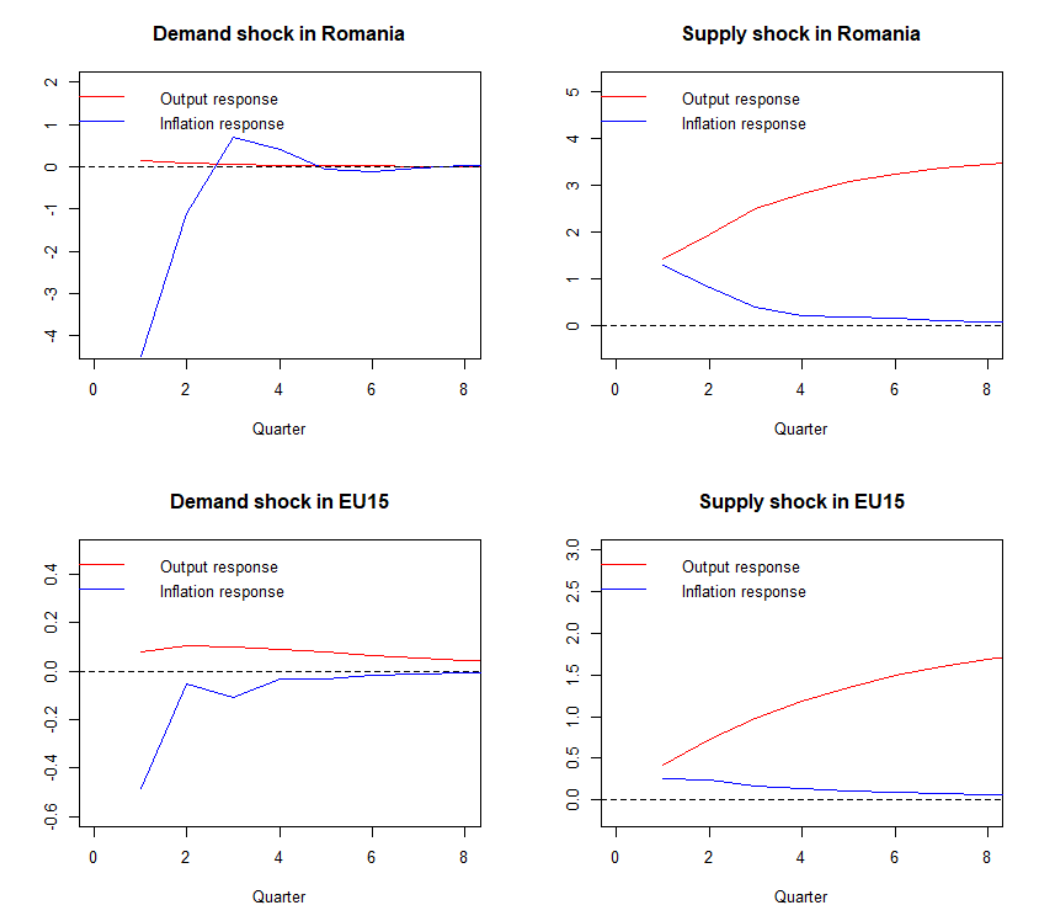
Figure 5. Mapping of the cumulative effects of positive supply and negative demand shocks on output and inflation rates for Romania and EU15. Source: own